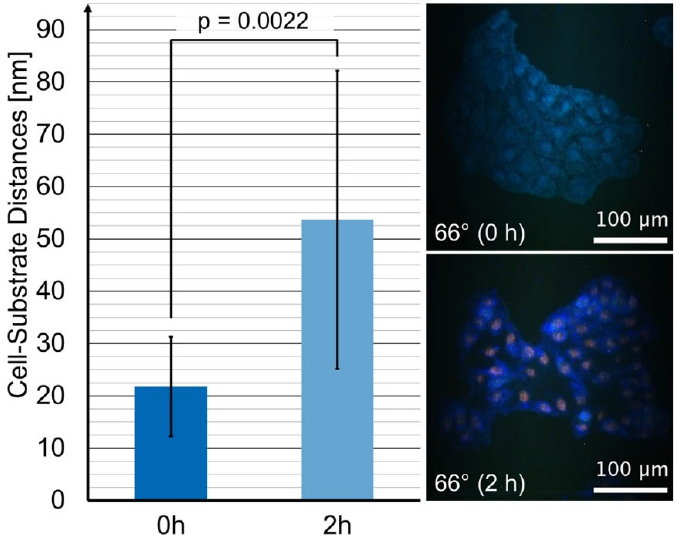
Figure 6. Cell ‐ substrate distances of MCF ‐ 7 breast cancer cells incubated with the fluorescence mem ‐ brane marker laurdan (8 μ M, 1 h) prior to and after incubation with doxorubicin (2 μ M, 2 h), as membrane marker laurdan (8 µ M, 1 h) prior to and after incubation with doxorubicin (2 µ M, 2 h), evaluated in the spectral maxima at 500–520 nm of VA ‐ TIRFM experiments of n = 11 samples in each as evaluated in the spectral maxima at 500–520 nm of VA-TIRFM experiments of n = 11 samples in case. Mean values ± standard deviations including p ‐ value for statistical significance ( p  0.05: sta ‐ each case. Mean values ± standard deviations including p -value for statistical significance ( p ≤ 0.05: tistically significant). TIRFM images of MCF ‐ 7 cells prior to (0 h) and after (2 h) incubation with statistically significant). TIRFM images of MCF-7 cells prior to (0 h) and after (2 h) incubation doxorubicin. with